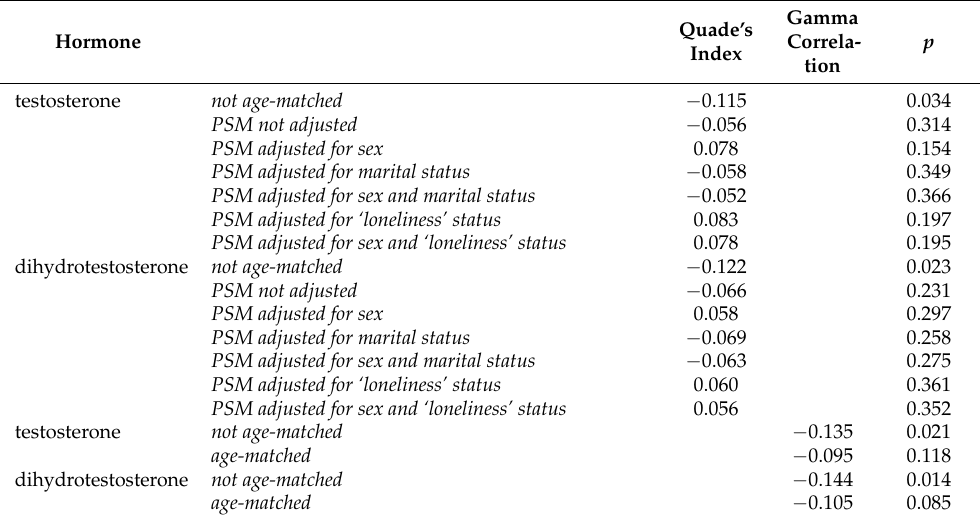
Table 6. Quade’s indices and gamma correlation coefficients for the associations between plasma concentrations of testosterone and dihydrotestosterone and the total GDS